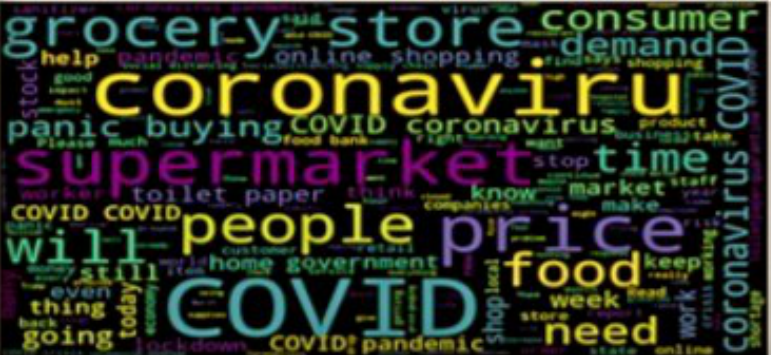
Figure 5. Word cloud of a